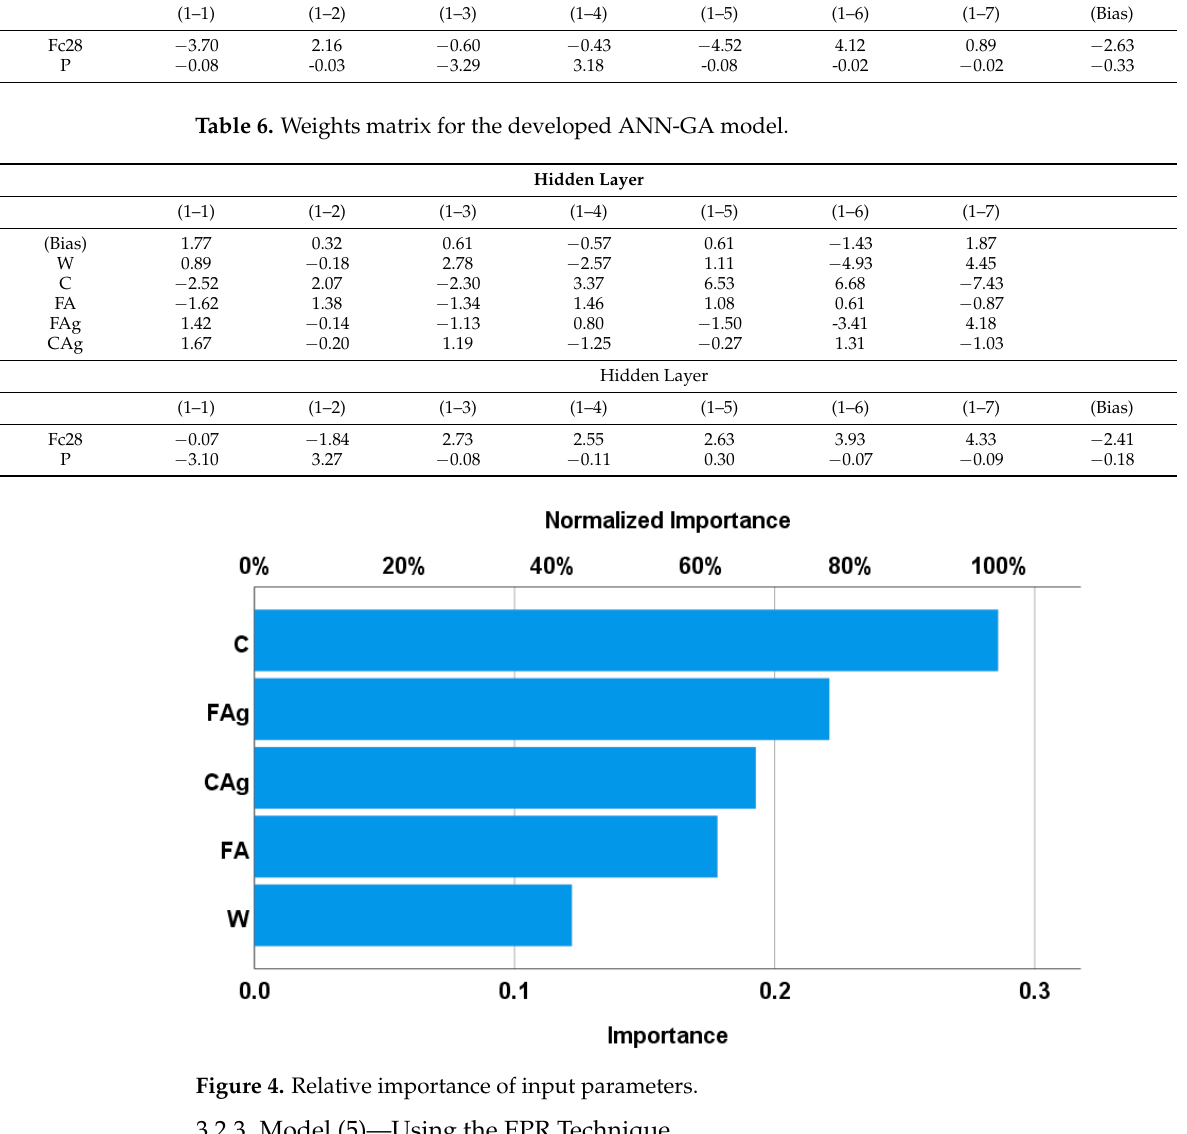
Figure 4. Relative importance of input parameters.